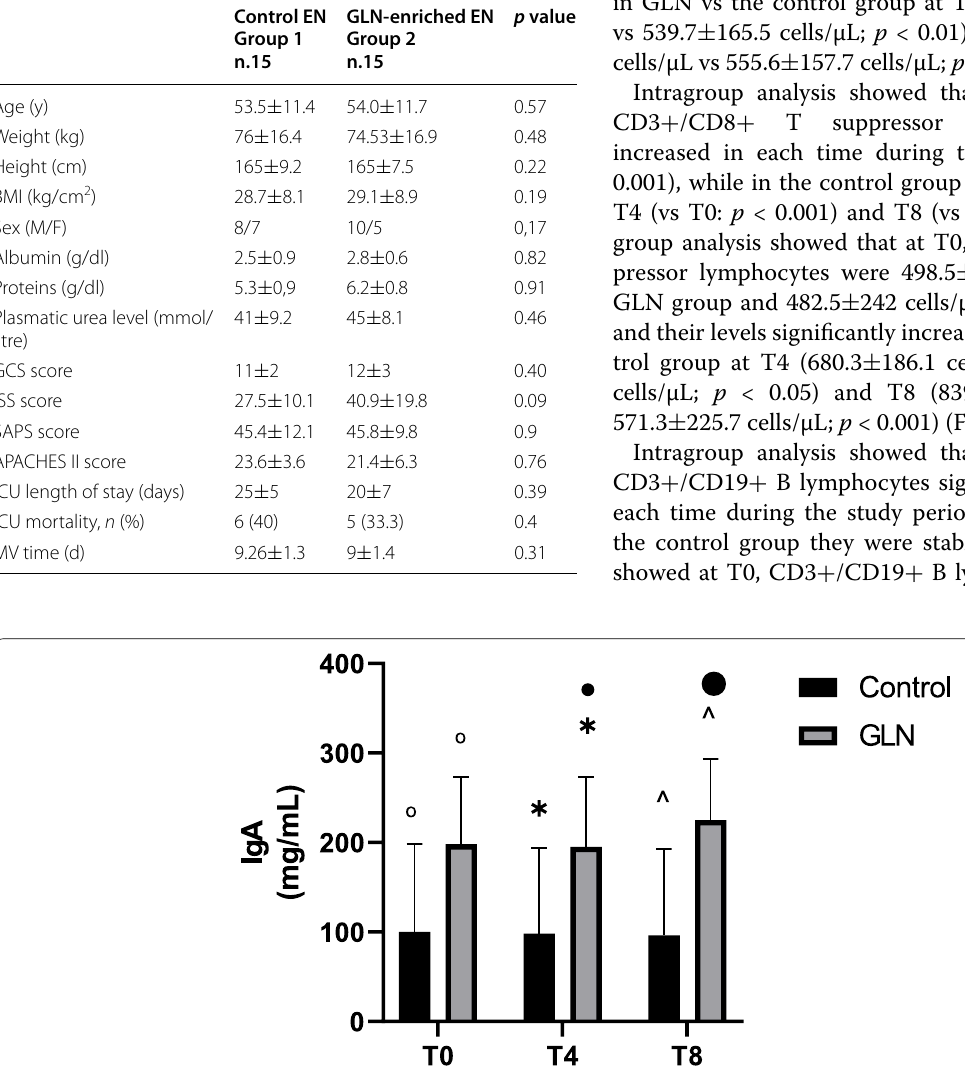
SD. °, * and ^ indicate a significant difference in GLN vs ±